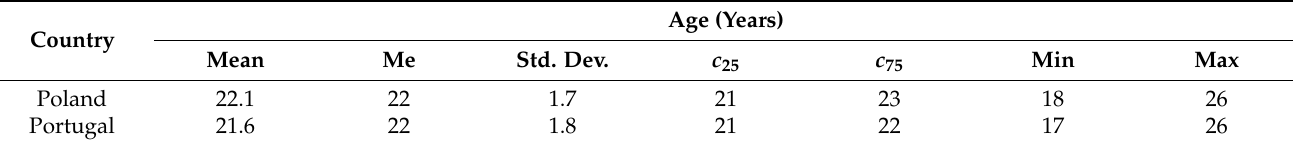
Table 1. Average age of respondents.